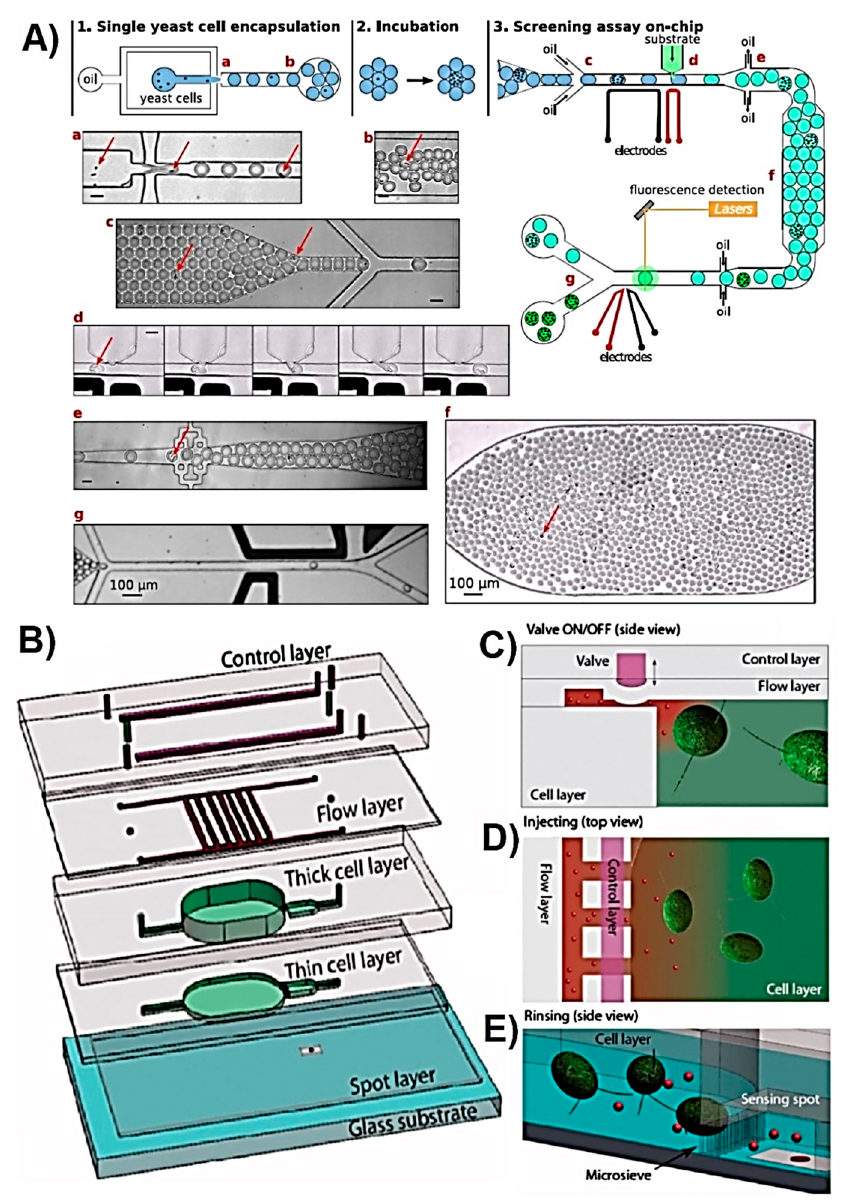
Figure 3. ( A ) Droplet-based microfluidic screening platform with denoted, a–f, microscopic images of the different steps of the microfluidic system. The red arrows indicate encapsulated Y. lipolytica cells. Unless specified, scale bars are 30 µm, reprinted from [58], copyright (2017), Springer Nature. ( B ) Multilayer microfluidic device for the optical monitoring of microalgae ROS metabolites. ( C ) Valve operation to control the connection between flow and cell layers. ( D ) Injection mode when the toxicant enters into the cell layer. ( E ) Rinsing mode when the toxicant leaves the cell layer through the microsieve, reprinted from [43], by permission of the publisher Taylor & Francis Ltd.,